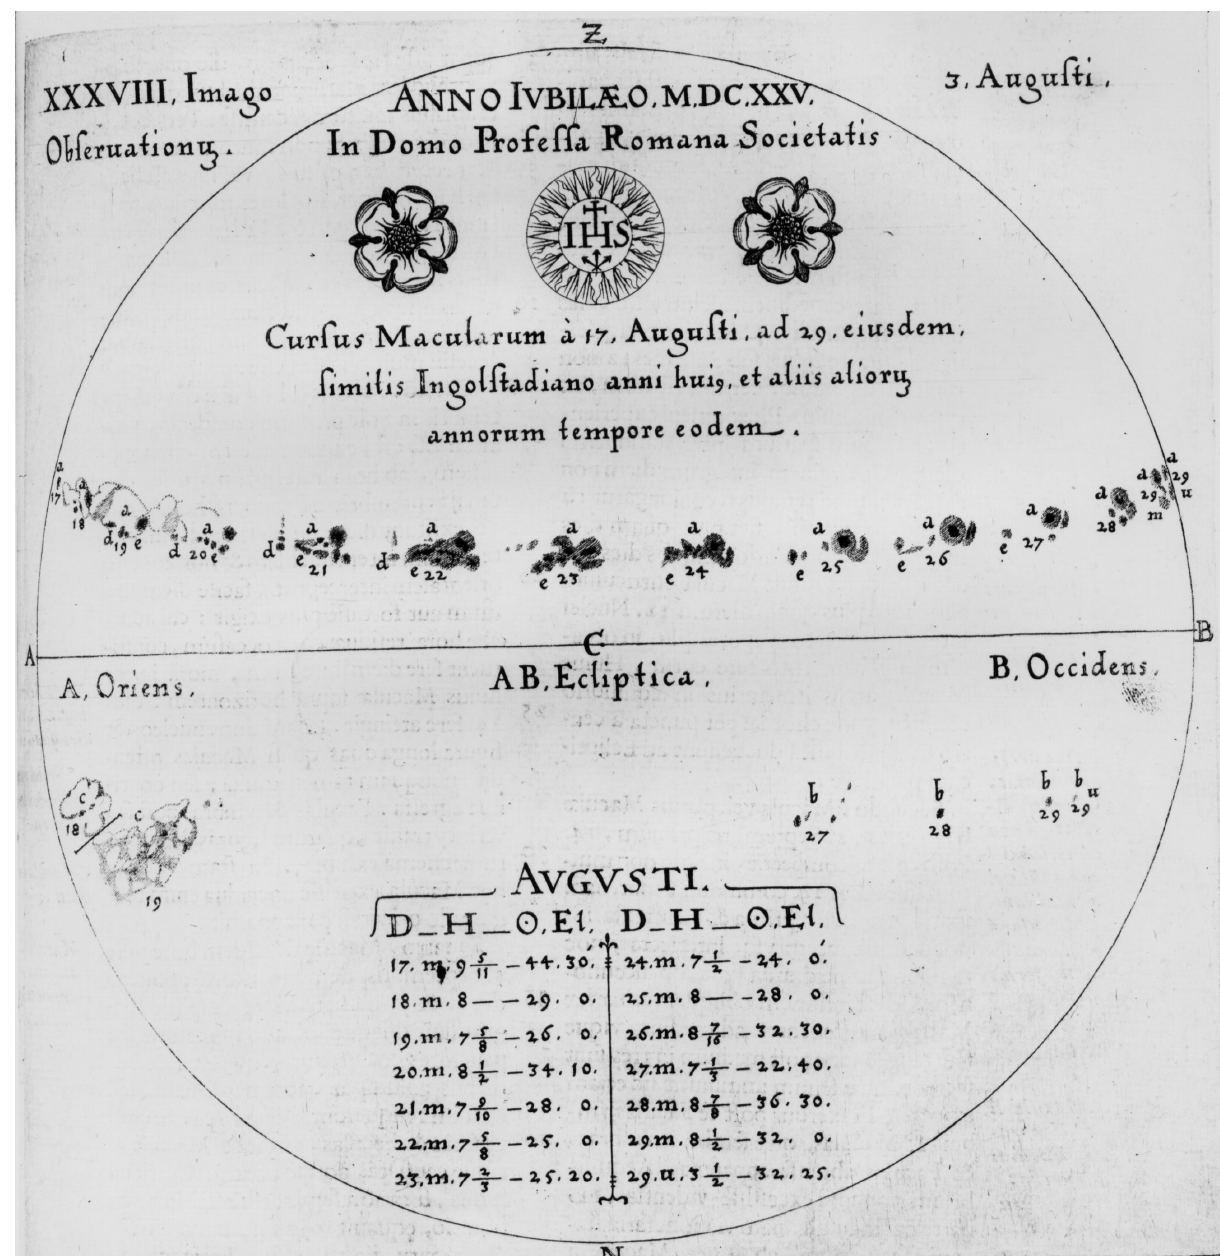
Fig. 3. The daily progression of sunspots across the solar disk during the interval AD 1625 August 17–29 (Scheiner, 1630). The complex sunspot group in the northern half of the solar disk that crossed the central meridian on August 23 (but was not observed in East Asia) is more likely to be associated with the Korean auroral observation on August 28 (see Table 1) than is the unaided-eye Chinese sunspot observation on September 2 (see Table